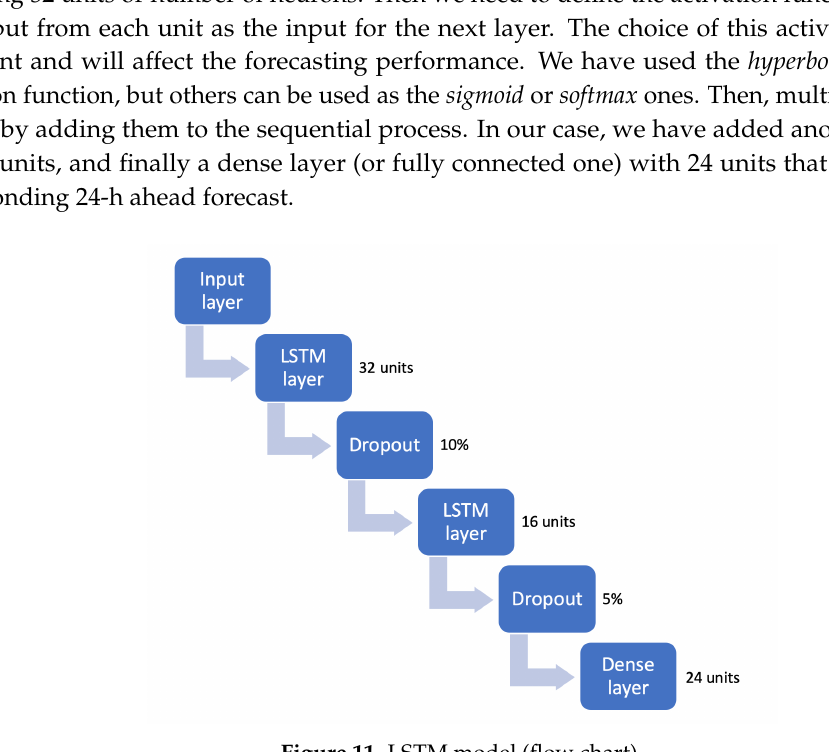
Figure 11. LSTM model (flow